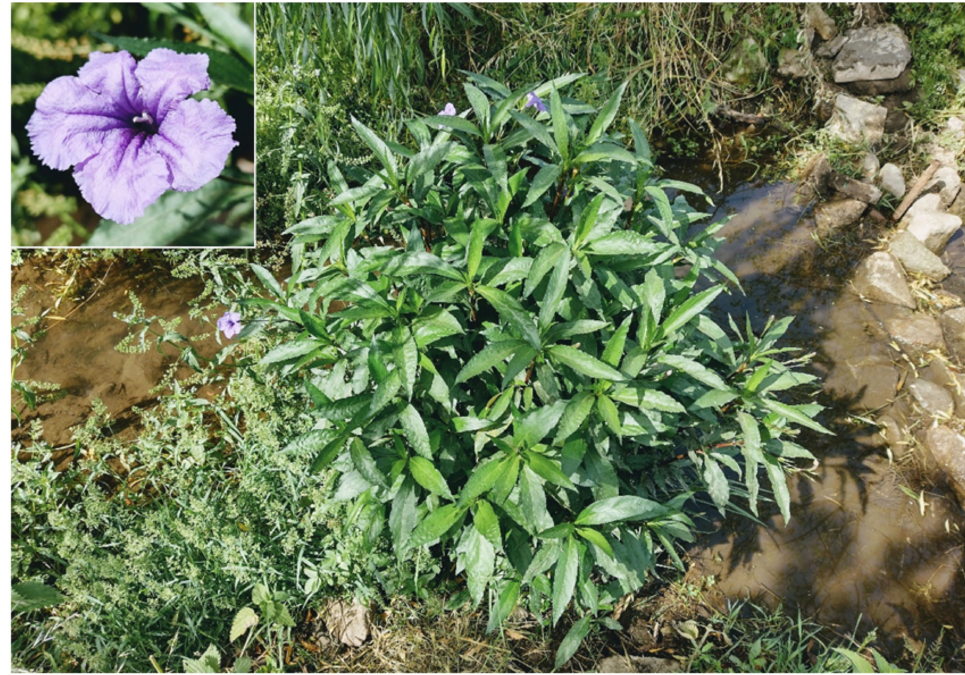
Figure 49. Ruellia simplex along channel Acqua Mariana (Acquedotti locality). Trachelospermum jasminoides (Lindl.) Lem. ( ≡ Rhynchospermum jasminoides Lindl.): this species is recorded in Italy as casual and only in two regions [33], i.e., Lombardy (just one site in Mantova Province; [90]) and Sardinia [just one site in Cagliari Province [91]). A small population was found in the Acquedotty locality on the cliff of channel Acqua Mariana (Figure 50), and it represents the first record for the Latium region and peninsular Italy (casual species) and the third one for Italy.